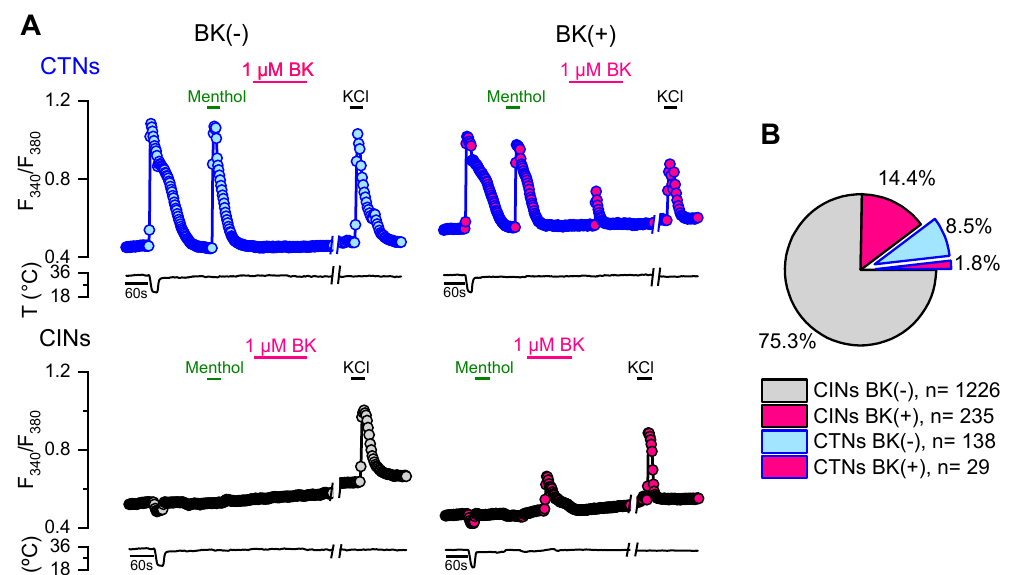
Figure 5. Evaluation of the functional expression of the bradykinin receptors in trigeminal CTNs. ( A ) Protocol in Ca 2+ imaging used to evaluate the responses of CTNs to cold, menthol (100 µM), bradykinin (1 µM) and KCl (30 mM); CINs are cold-insensitive neurons. The traces correspond to examples of a CTN/BK( − ), CTN/BK(+), CIN/BK( − ), CIN/BK(+) from TG neurons. ( B ) Pie plot showing the percentage of the different populations of trigeminal primary sensory neurons.